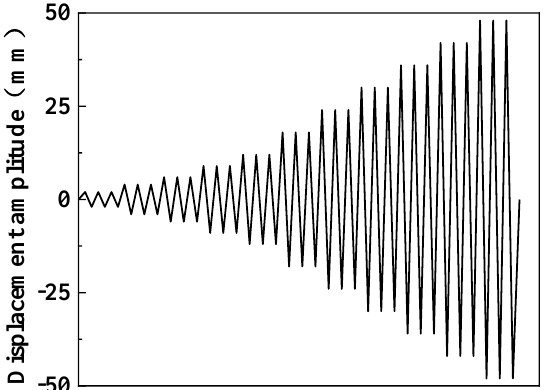
Figure 22. Loading procedure for the low cyclic loading test.